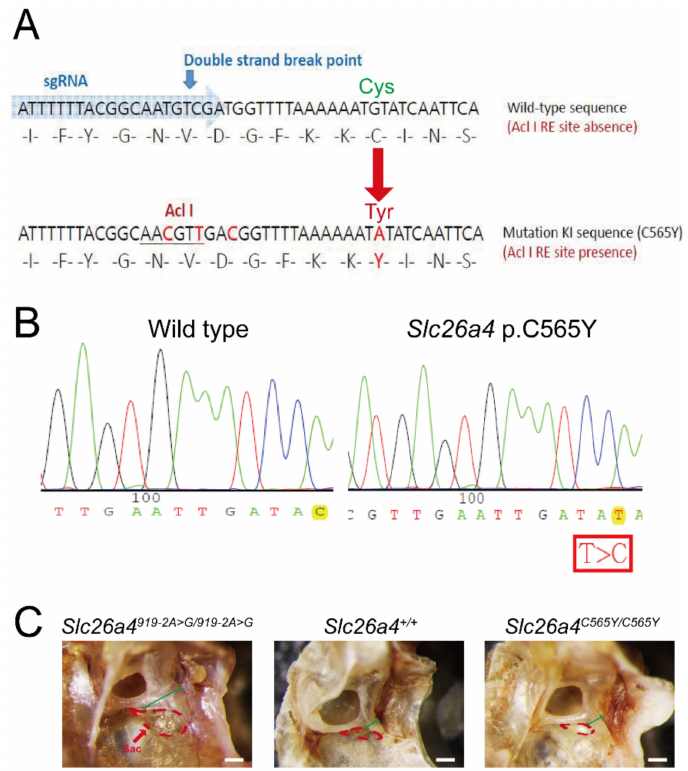
Figure 1. Generation of mice with Slc26a4 p.C565Y variant using clustered regularly interspaced short palindromic repeat (CRISPR)/Cas9. ( A ) Design diagram. Single guide RNA (SgRNA) for CRISPR/Cas9 and silent mutations for enzyme cutting sites (for checking) were designed to incorpo- rate mutations into the genome of C57BL/6 mice. To generate the Slc26a4 p.C565Y variant, codon TGT was mutated to TAT. ( B ) Sanger sequencing was performed to confirm nucleotide changes in transgenic mice. Sequence was read in reverse. ( C ) Gross morphology. Enlargement in endolym- phatic sac (region delineated by red dotted line) and vestibular aqueduct (marked by green line) was observed in the Slc26a4 919-2A>G/919-2A>G mice, but not in Slc26a4 +/+ and Slc26a4 C565Y/C565Y mice (bar = 100 µ